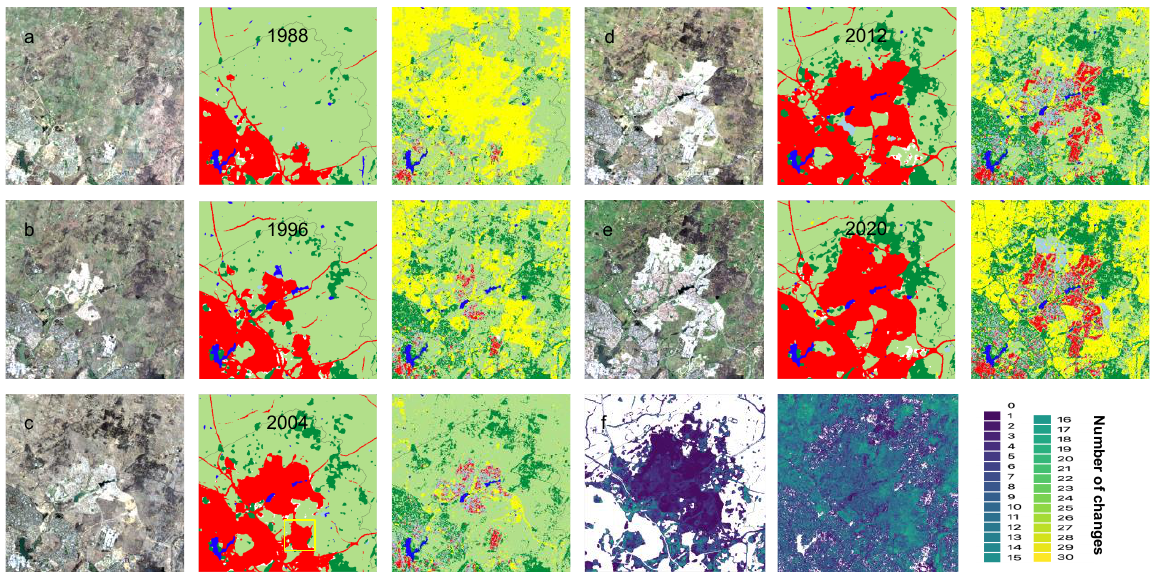
Figure 11. Gungahlin area in the north of Canberra showing the growth of urban areas, with ( a – e ) for every eighth year from 1988 to 2020, triplets showing the Landsat geomedian RGB True Colour composite (left), and six-class simplified land cover maps (for legend see Figure 10) from our CNN mapping (centre) and the DEA Land Cover product (right). Area is ~14 km × 14 km centred on 35.18°S, 149.12°E. ( f ) number of class transitions (legend at right) over 1988–2020 for our CNN model (left) and the DEA Land Cover product (right).